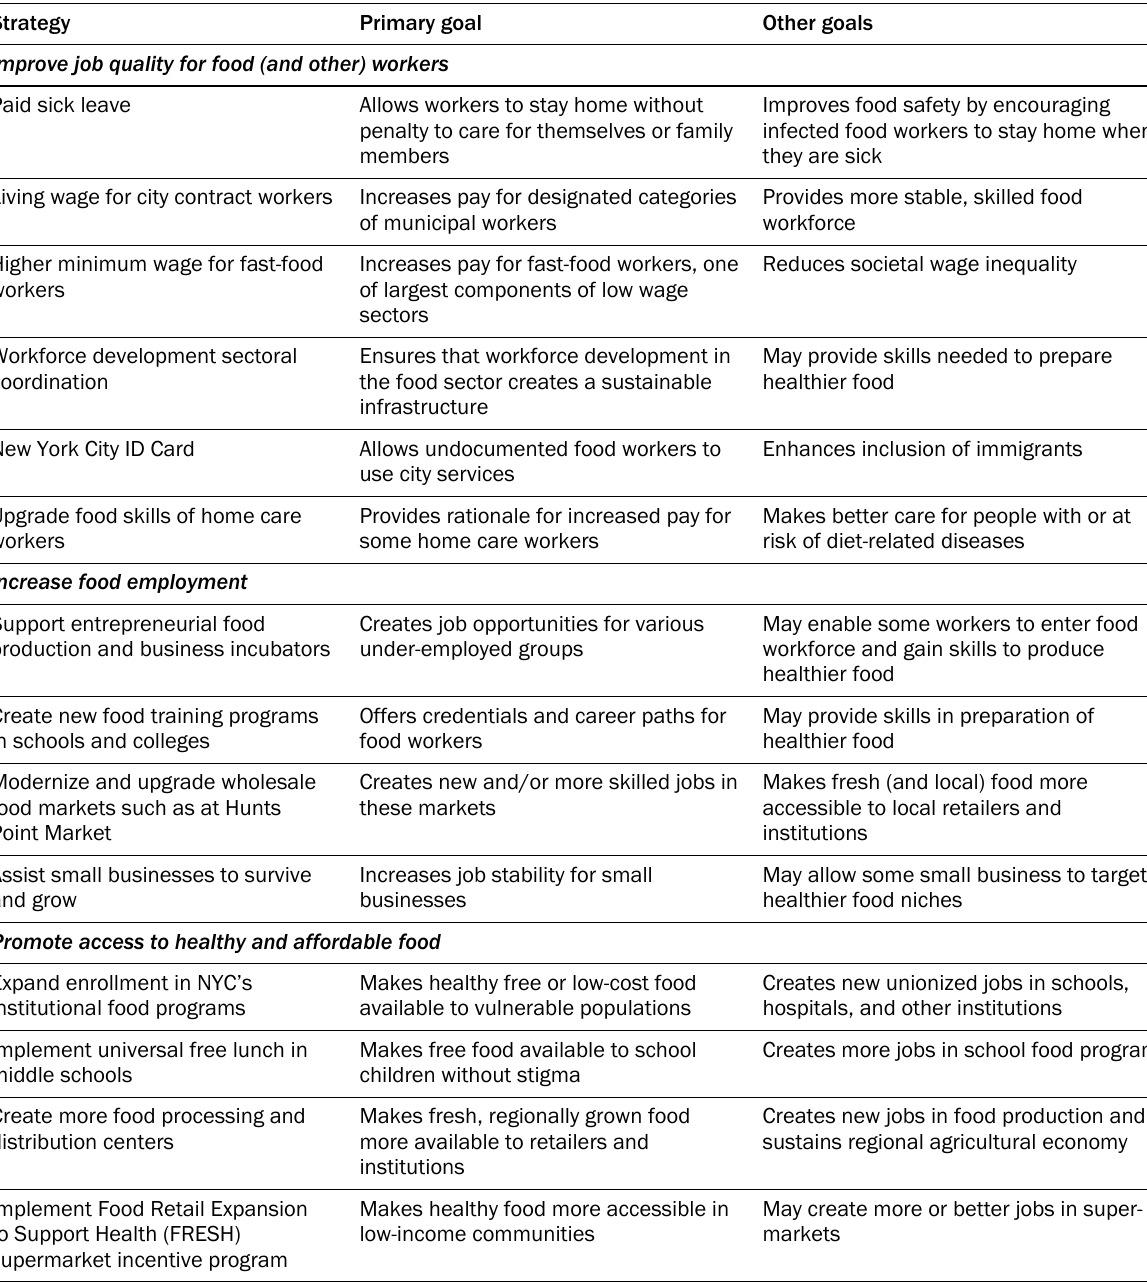
Table 4. Selected Strategies for Growing Good Food Jobs in New York